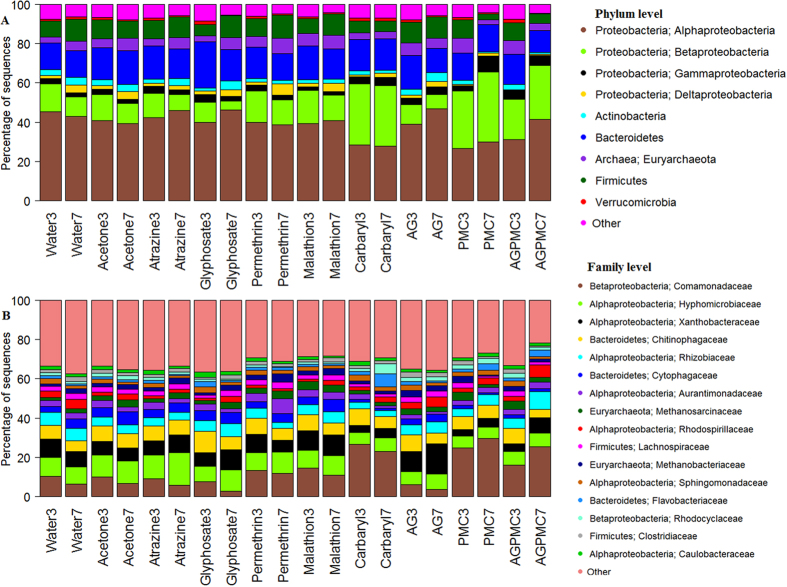
Composition of bacterial and archaeal communities at (A) phylum and (B) family level in water samples from different pesticide treatments. Taxa with abundance less than 1% and 1.6% of total sequences were pooled together as “Other” at the phylum and family level, respectively.